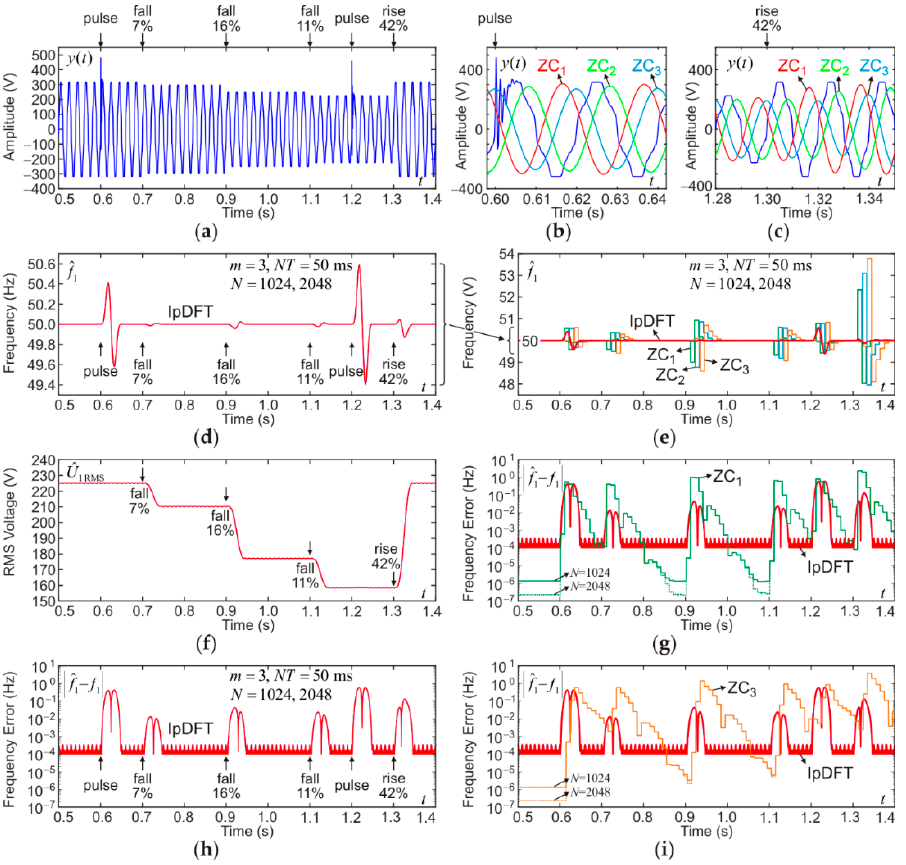
Figure 19. Effect of the sum of distortions by harmonics, low-frequency pulse, voltage dip, and voltage rise on the estimation results: ( a ) time domain signal distorted with harmonics and two pulses (at 0.6 s and 1.2 s) and four voltage steps (at 0.7 s, 0.9 s, 1.1 s and 1.3 s); ( b , c ) filter output signals for ZC method; ( d , h ) estimation result of IpDFT method for m = 3 at 50 ms measurement time and for N = 1024 and 2048; ( f ) rms measurement of fundamental component for voltage step detection; ( e , g , i ) comparison of accuracy of IpDFT method for m = 3 and NT = 50 ms with ZC method (for ZC 1 and ZC 3 ) for N = 1024 and